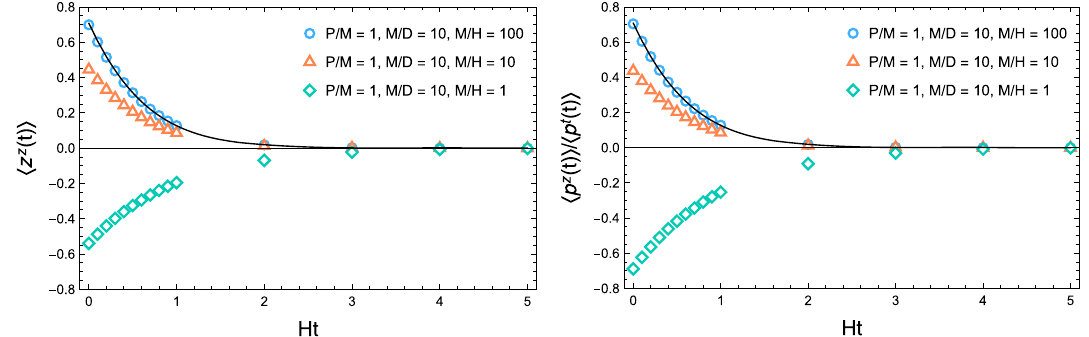
Fig. 3 Left: Numerical calculation of (cid:7)˙ z ( t ) (cid:5) which corresponds to the velocity expectation value of the wave packet, where the dot stands for the differentiation with respect to t . The classical velocity ˙ z ( t ) fol- lows from (55) and is shown by the black solid curve. Right: This